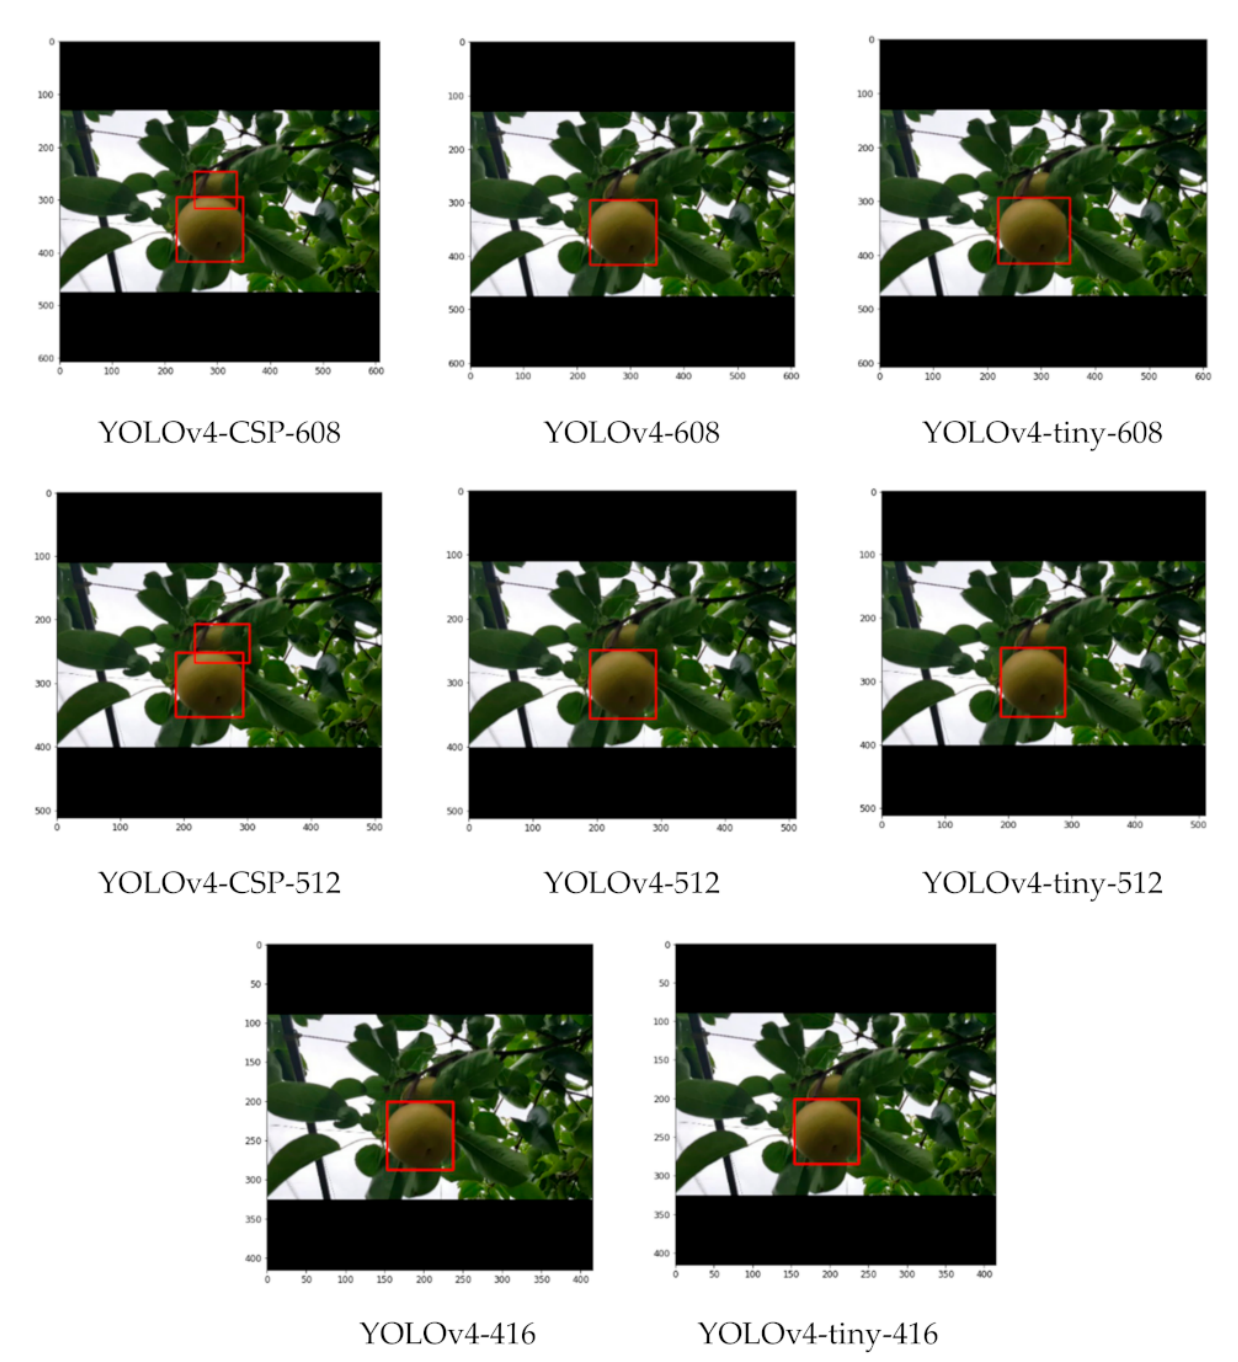
Figure 21. Example detections from the different YOLOv4 models using a close-up image with a high degree of occlusion but good